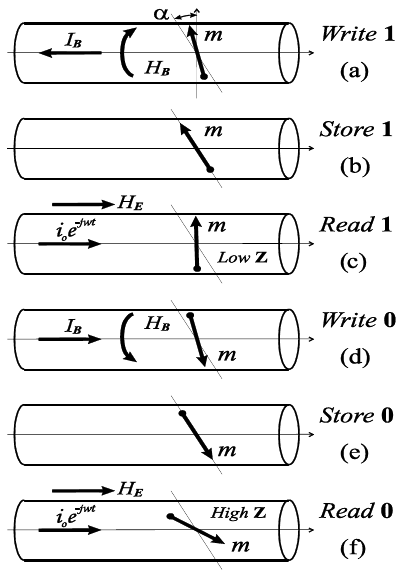
Figure 12. Principle of data storage in wire element.  is the angle between the anisotropy easy axis and the transversal